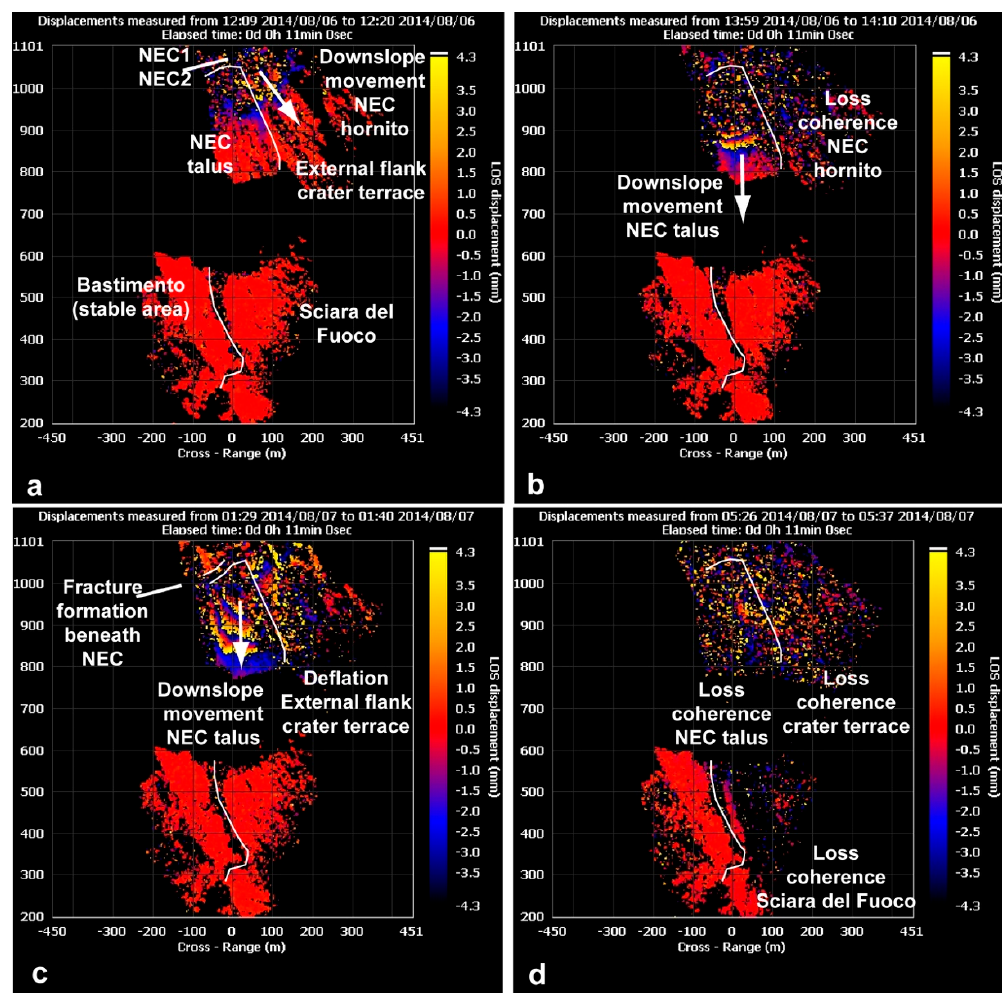
Figure 5. GBInSAR interferograms formed using a pair of images recorded between ( a ) the 12:09 and 12:20 on 6 August 2014, evidencing the instability of the NEC-hornito; ( b ) the 13:59 and 14:10 on 6 August 2014, evidencing the instability of the NEC-talus; ( c ) the 01:29 and 01:40 on 7 August 2014, evidencing the concomitant instability of the NEC-talus and the deflation of the crater terrace, coherent with the sliding of the NEC-talus induced by the NE-ward magma migration from the crater terrace; ( d ) the 05:26 and 05:37 on 7 August 2014, characterized by loss in SAR coherence due to fast movement both in the crater area (sliding processes) and along the SdF (lava flow emplacement). Interferograms in ( a ), ( b ), and ( c ) are affected by phase wrapping. At 05:04 V1 opened at ~650 m a.s.l. (Figure 4) and at 05:08 the NE flank of NEC1 started